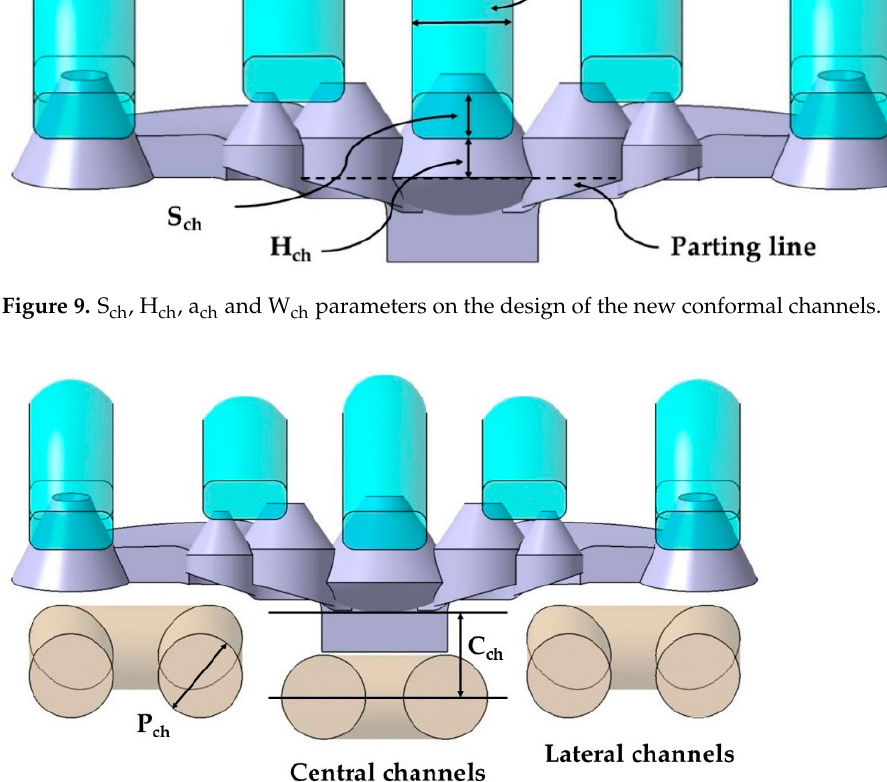
Table 2. Parameters of the cavity plate cooling